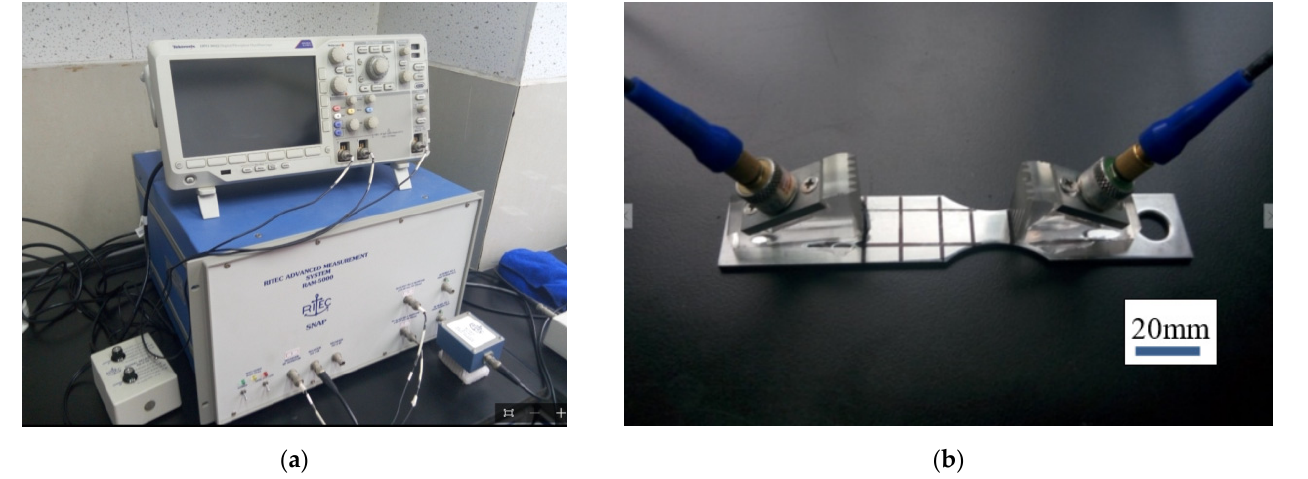
Figure 5. Nonlinear ultrasonic test system. ( a ) RitecSNAP ultrasonic system; ( b ) specimen and ultrasonic piezoelectric transducer.